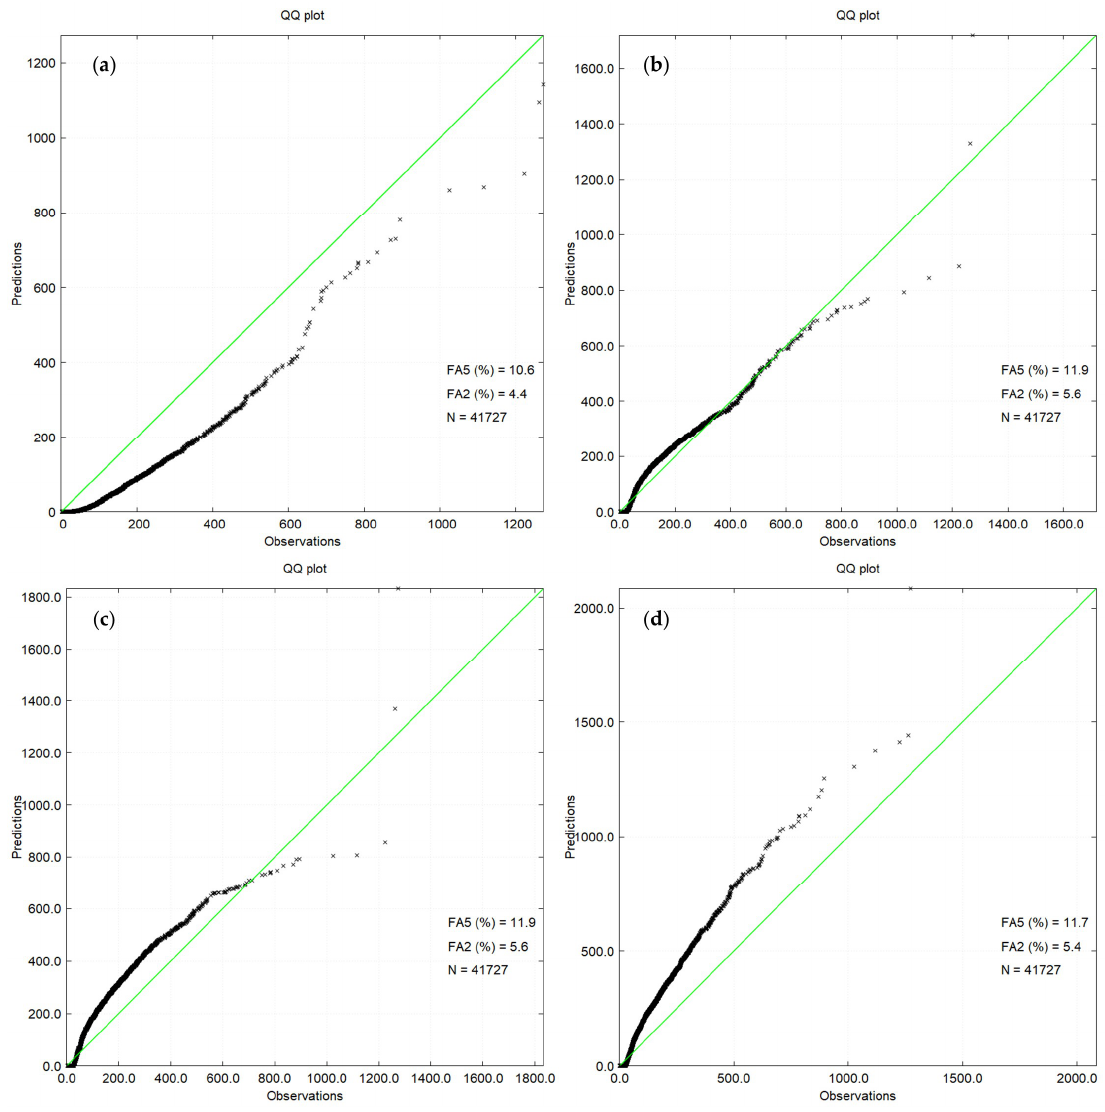
Figure 8. QQ plot of ( a ) AERMOD, ( b ) LAPMOD WT, ( c ) LAPMOD JJ + RS and ( d ) LAPMOD JJ + JJ for one-hour concentrations of Kincaid SO 2 (μg m −3 ). Table 7. Statistics for the Kincaid SO 2 observations ( µ g m − 3